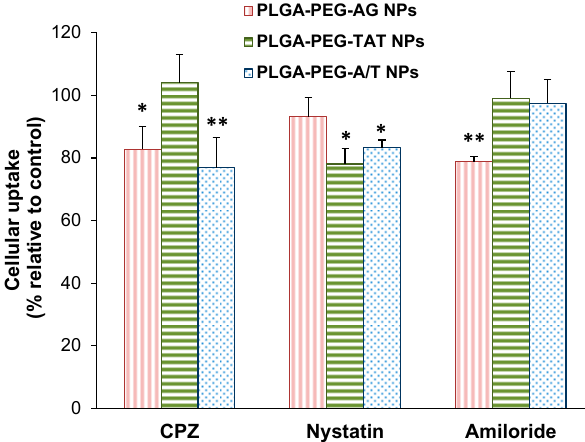
Figure 5. Effects of endocytosis inhibitors on cellular uptake of PLGA-PEG-AG NPs, PLGA-PEG-TAT NPs and PLGA-PEG-A/T NPs in CD133(+) H69 cells. (* p < 0.05, ** p < 0.01, compared to NPs without pre-treated by inhibitors, n = 3).